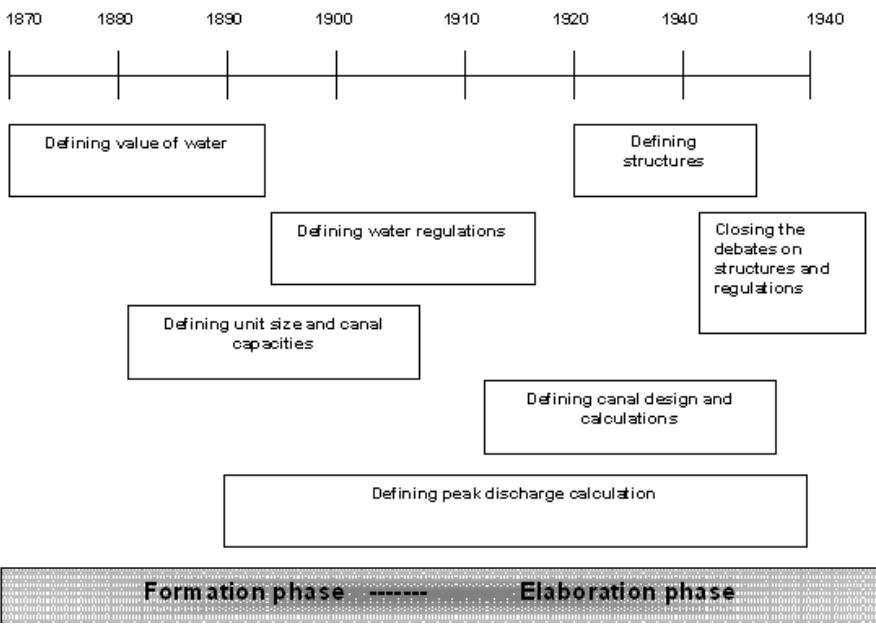
Figure 6 Regime phases in the Netherlands East Indies